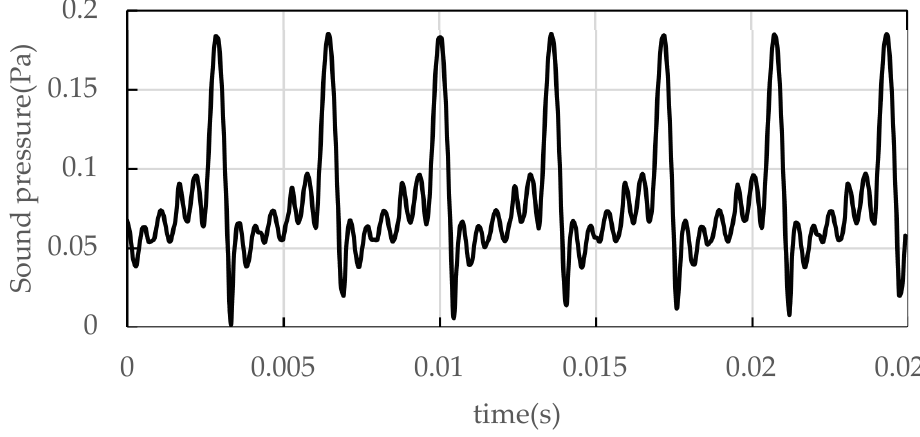
Figure 5. Calculation results of fan noise in the time domain.